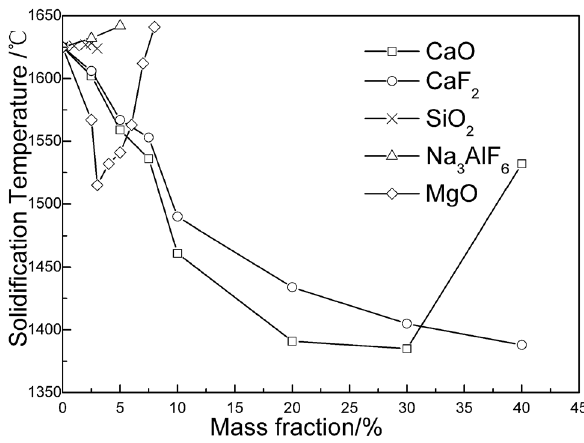
Figure 4: E ff ect of di ff erent additives on liquidus temperature of